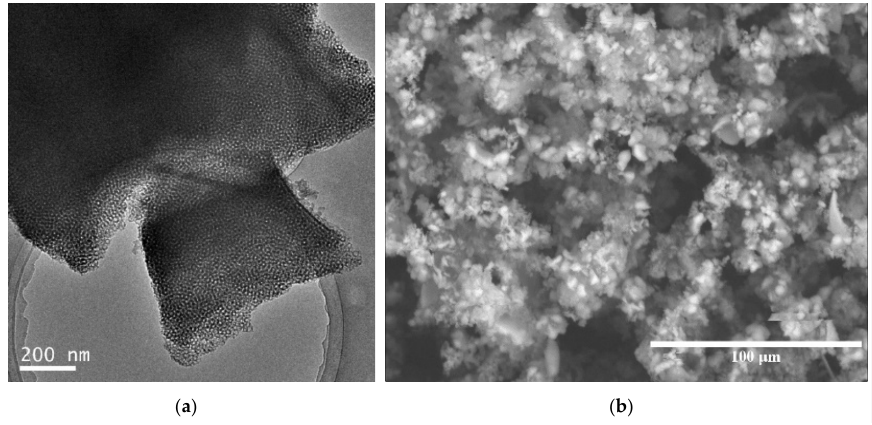
Figure 9. Structure and morphology of large pore size E-PMO-S material ( a ) TEM and ( b ) SEM images.